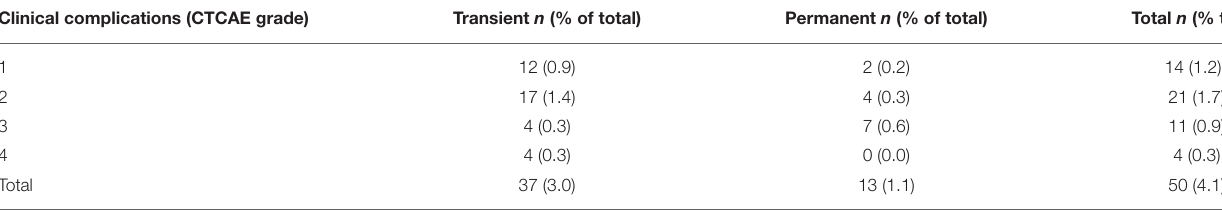
TABLE 4 | Fraction of transient or permanent complications among all complications. Clinical complications (CTCAE grade)